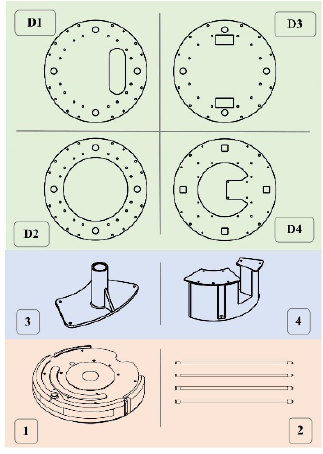
Figure 2. UVBot key mechanical components. (D1) Designed to mount the LiDAR, (D2) serves as support, (D3) used to house electronic components such as power and the ballast, and (D4) serves to mount the Raspberry Pi 3B. (1) is the iRobot Create 2, (2) is the UV lamps, (3) is 3D printed lamp holder, (4) is 3D printed support structure. All components were either purchased off the shelf (salmon-colored boxes), 3D printed in PLA using FDM printing (blue-colored boxes), or laser-cut (green-colored boxes).